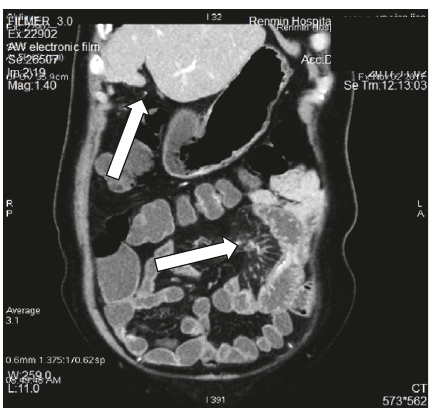
Figure 1: CT scan showing atrophy of the right liver lobe with hypertrophy of the left and caudate lobes, mesenteric edema.